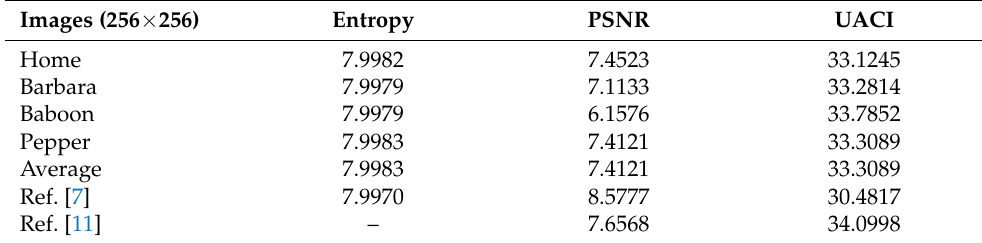
Table 9. Statistical measures of grayscale cipher images.